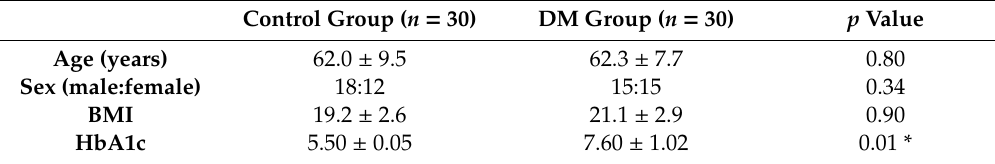
Table 1. Demographics and Baseline Clinical Characteristics of the Study Participants.